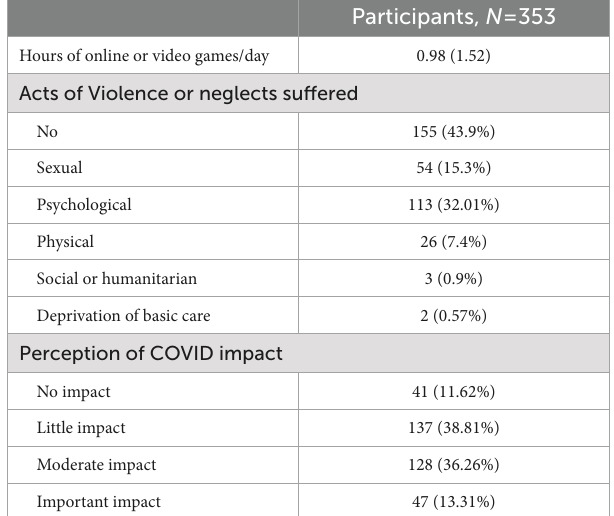
TABLE 1 Description of the socio-demographic data of the